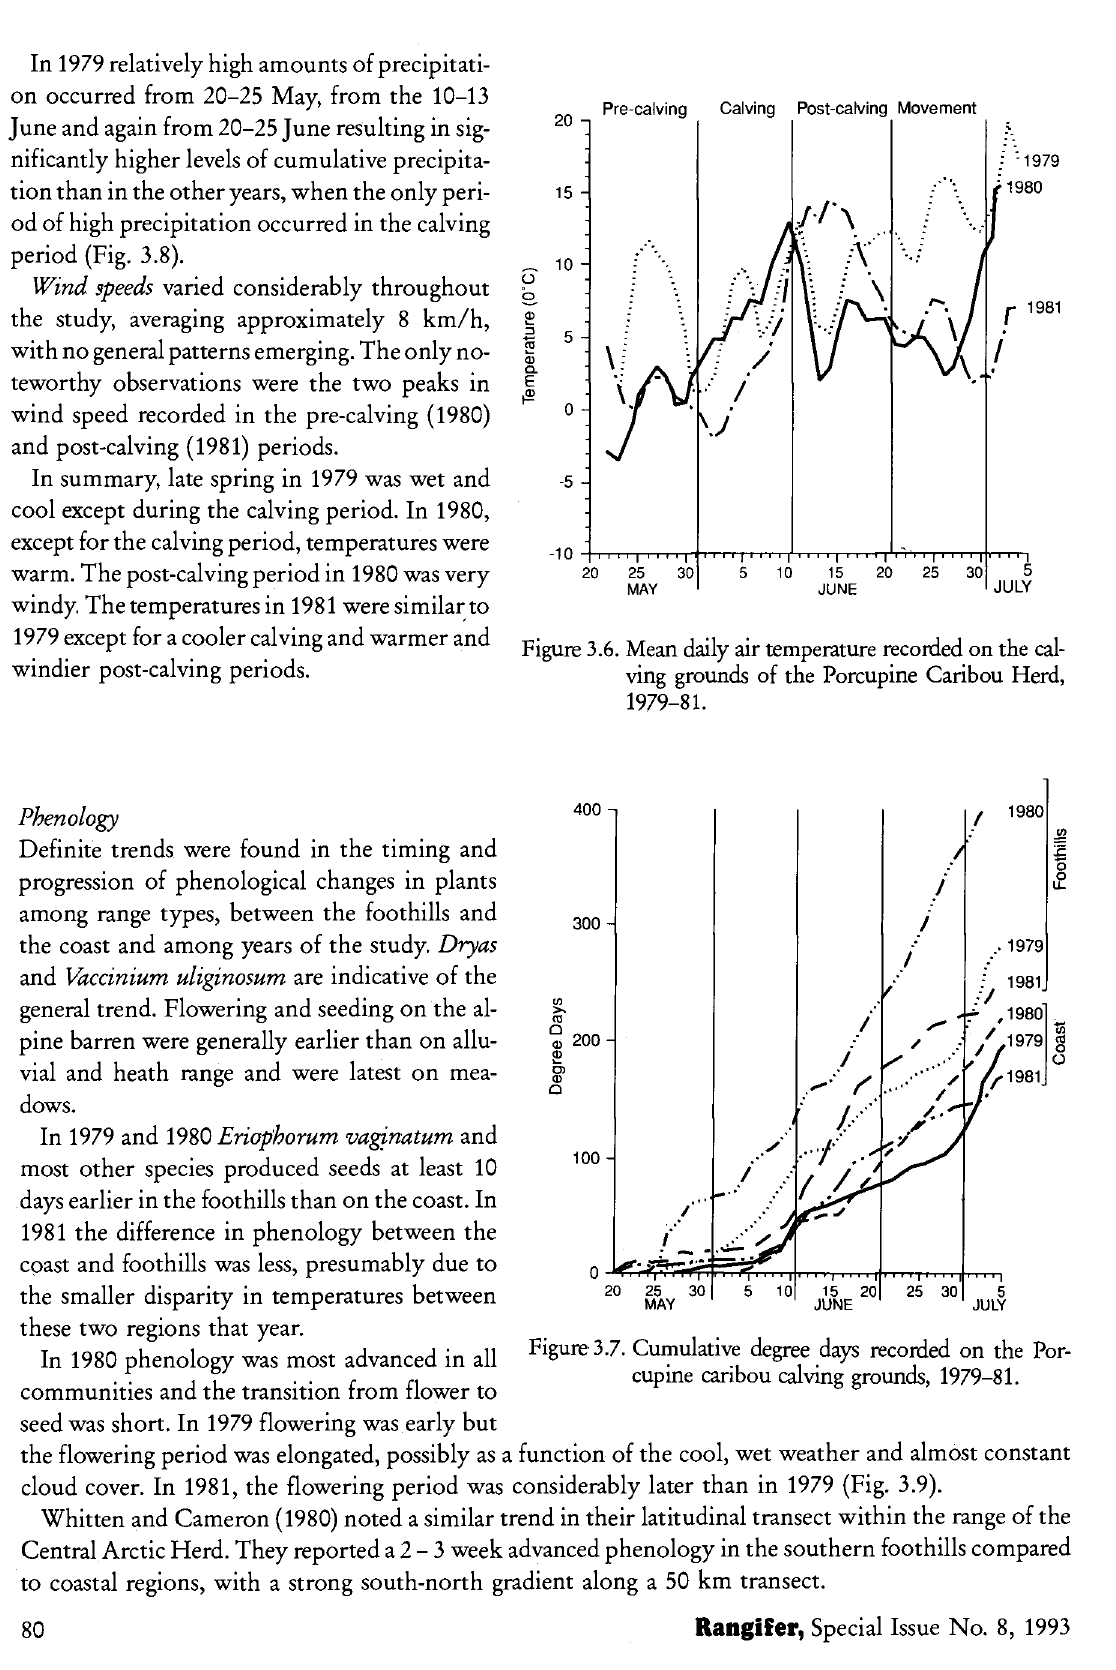
Figure 3.7. Cumulative degree days recorded on the Por cupine caribou calving grounds,